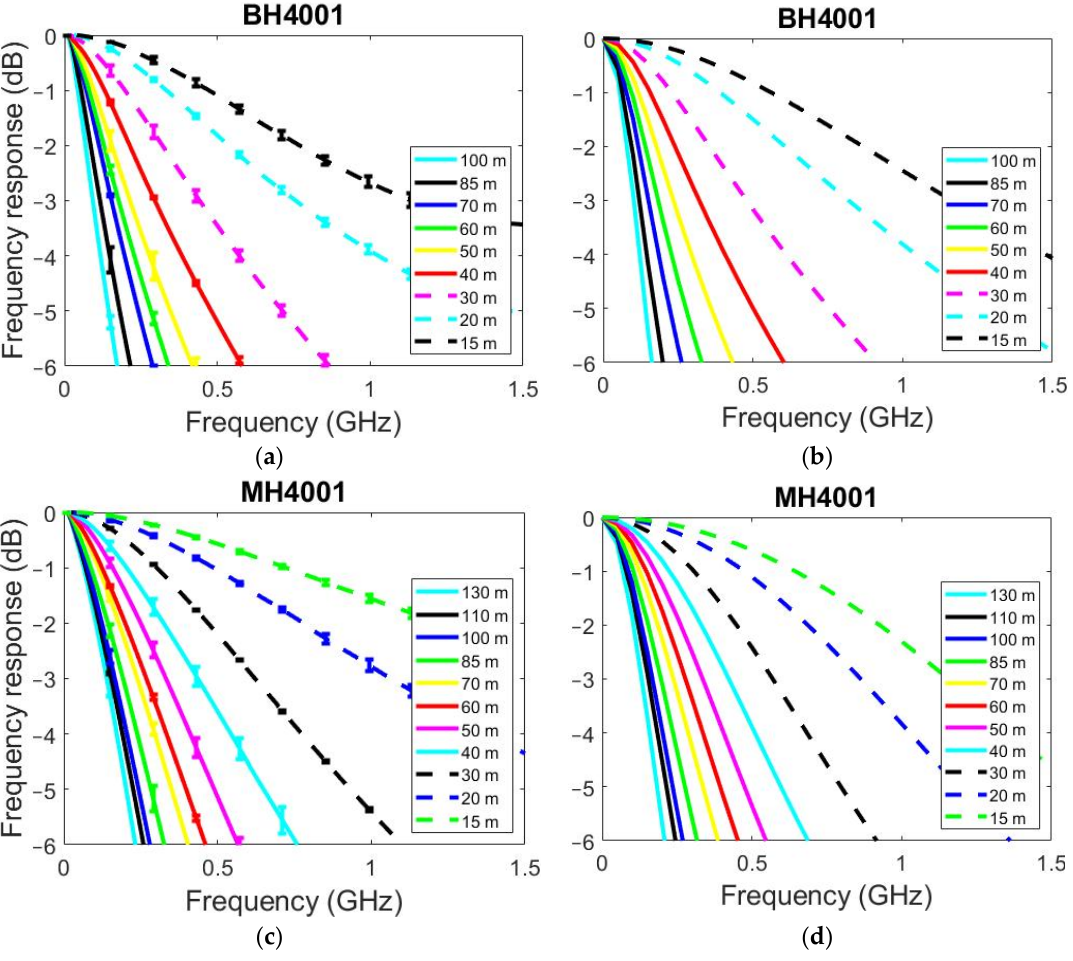
Figure 4. Normalized frequency response at selected fiber lengths. ( a , c ) Normalized frequency response measurements for BH4001 and MH4001 fibers respectively, ( b , d ) Normalized frequency response modeled results for BH4001 and MH4001 fibers respectively.